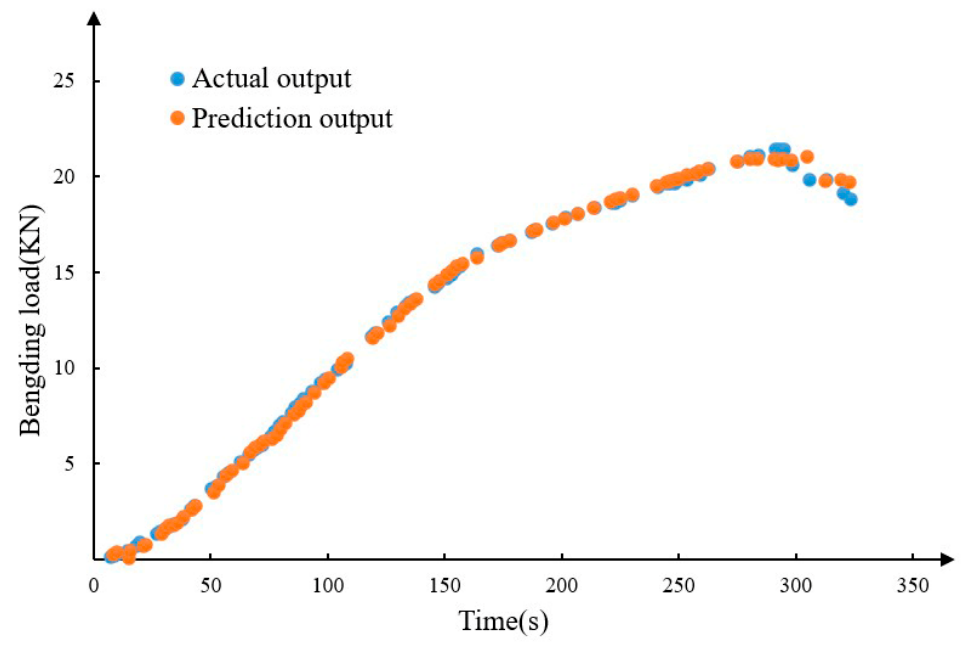
Figure 8. Comparison of sample predicted output and actual output.